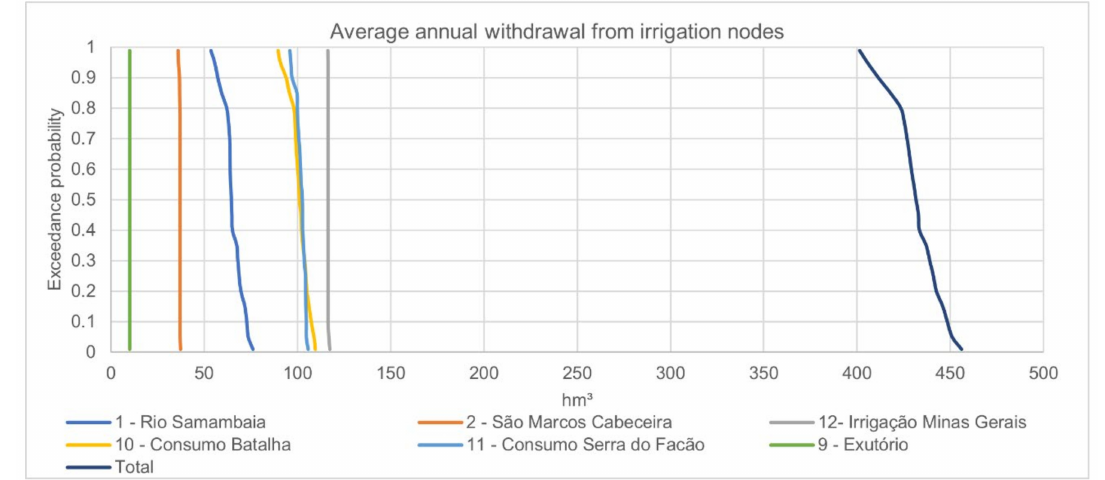
Figure 6. Exceedance curves of water withdrawals in each system node. Table 3. Demands, water withdrawals, and deficits for irrigated agriculture in both scenarios in the economic arrangement. Node